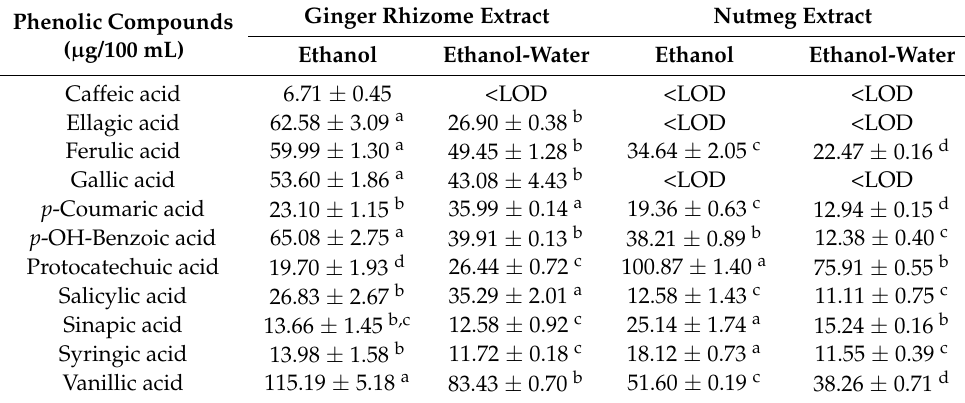
Table 6. Content of phenolic acids ( x ± SD ) in ginger rhizome and nutmeg extracts obtained with the optimal grinding process and storage time. Ginger Rhizome Extract Nutmeg Phenolic Compounds ( µ g/100 mL)